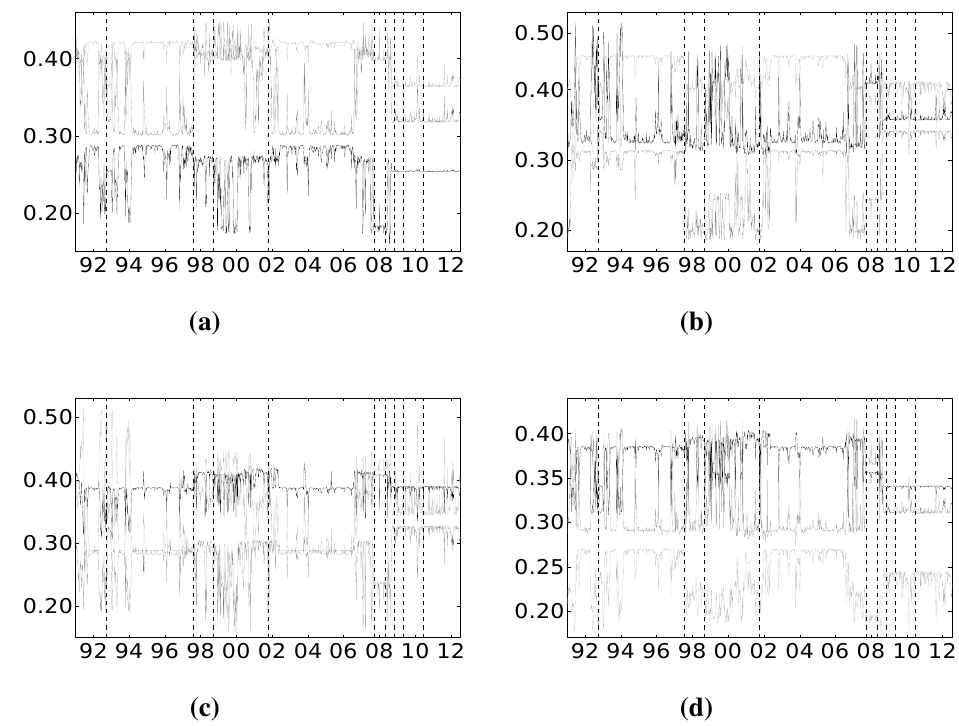
Figure 5. Shalpey value ∆ M -CoES of the different sectors against banks ( a ), financial services ( b ), life insurance ( c ) and non-life insurance ( d ). Vertical dotted lines represent major financial downturns: see Figure 1 for a detailed description. (a) Financial services (light gray), life (gray) and non-life (dark) insurance against banks; (b) banks (light gray), life (gray) and non-life (dark) insurance against financial services; (c) banks (light gray), financial services (gray) and non-life insurance (dark) against the life insurance index; (d) banks (light gray), financial services (gray) and life insurance (dark) against the non-life insurance index.